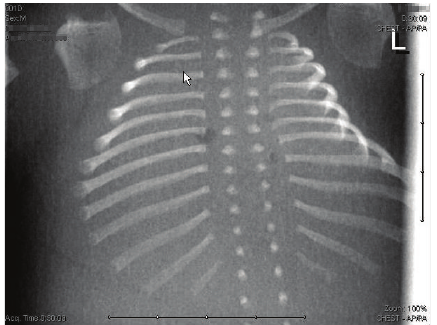
Figure 3: Postmortem radiograph showing complete absence of calcification of the vertebral